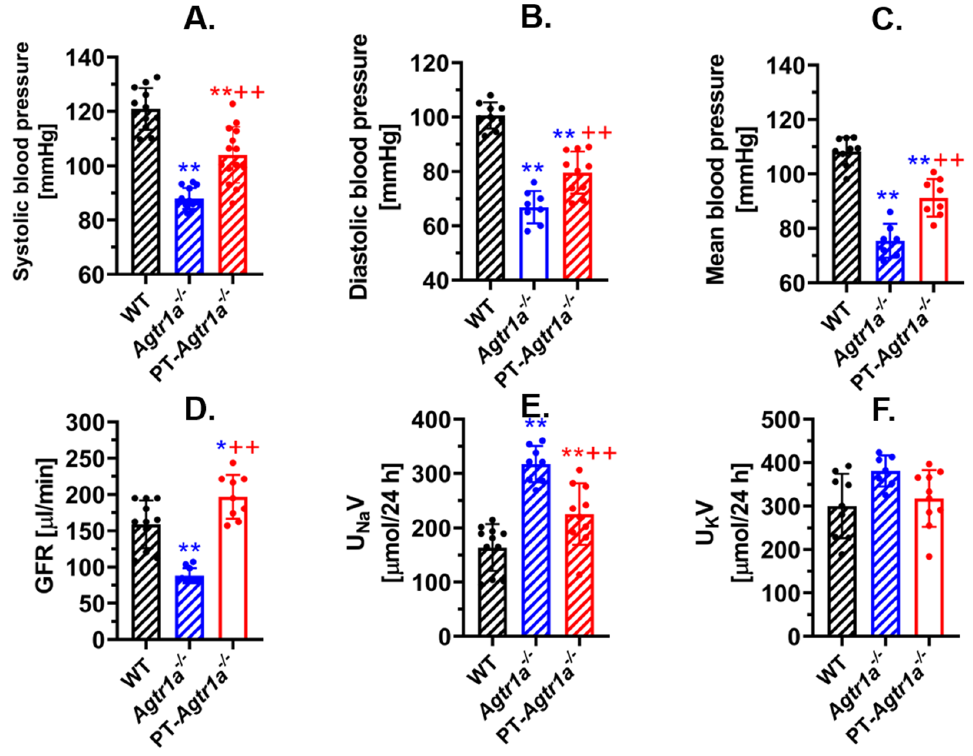
Figure 2. Effects of global or proximal tubule-selective deletion of AT 1a receptors on basal systolic, diastolic, and mean arterial blood pressure ( A – C ), glomerular filtration rate ( D ), and natriuretic response ( E ) in whole-body Agtr1a -/- or proximal tubule-specific PT- Agtr1a -/- mice compared with wild-type mice. Note that Agtr1a -/- mice showed that basal blood pressure was ~30 mmHg lower than wild-type mice, whereas PT- Agtr1a -/- mice had basal blood pressure ~15 mmHg lower than wild-type mice, respectively. ( F ) shows no changes in 24 h urinary potassium excretion. * p < 0.05 or ** p < 0.01 vs. WT mice; ++ p < 0.01 vs. global Agtr1a -/- mice. Reproduced from Reference [28] with permission.